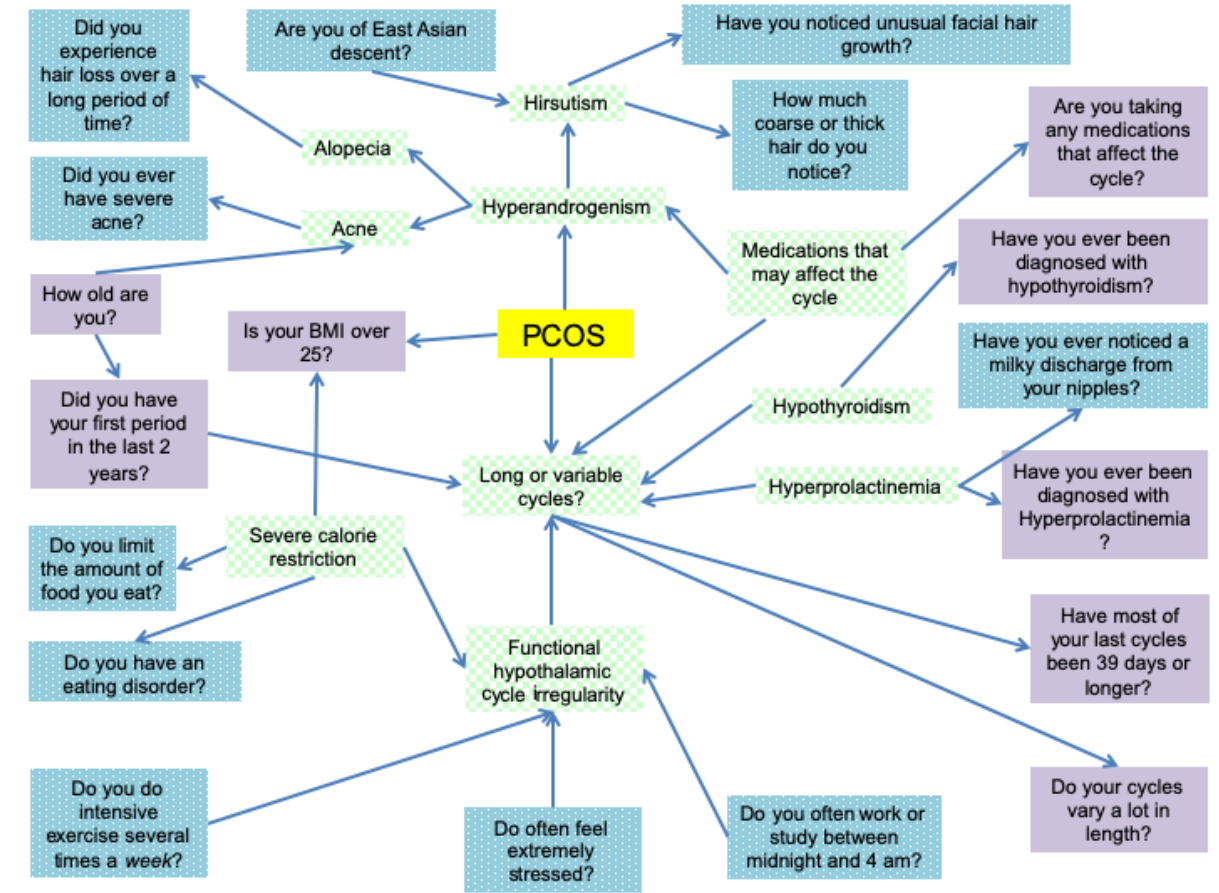
Figure 1. Green, checkered boxes indicate major diagnostic concerns for polycystic ovary syndrome. Purple, solid boxes are representative of the questions that are on the screen. The blue, dotted boxes are additional questions asked by the irregular cycle feature. PCOS: polycystic ovary